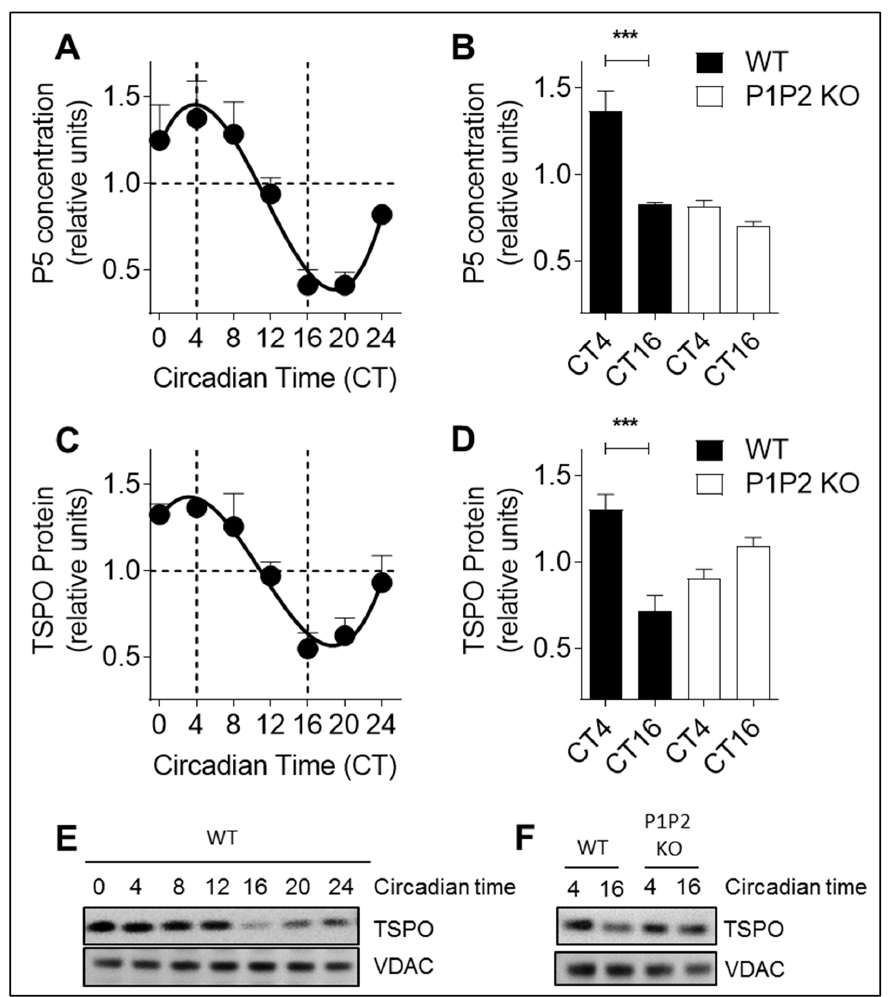
Figure 2. Pregnenolone and TSPO oscillations are dependent on a functional circadian clock in mouse brains. ( A ) P5 concentration was quantified in brain homogenates from non-fasted wild-type mice kept in constant darkness using a direct pregnenolone ELISA test. Circadian times from CT0 to CT24 are shown. All data are normalized to 1 and presented as mean ± SEM (one experiment, seven time points, n = 3–4 for each time point). ( B ) Variations in P5 concentration are abolished in PER1 / PER2 (P1P2) knock-out (P1P2 KO) mice. P5 levels at peak and trough corresponding to CT4 and CT16 from brain homogenates of wild-type (WT) mice compared to P1P2 KO mice. All data are normalized to 1 and presented as mean ± SEM (WT and P1P2 KO: one experiment, two time points, n WT = 8 and n P1P2 KO = 3–4 for each time point). *** p < 0.001 (unpaired Student’s t -test). ( C ) TSPO protein levels were analyzed in brain homogenates from non-fasted wild-type mice kept in constant darkness by immunoblotting. Circadian times from CT0 to CT24 are shown. All data are normalized to 1 and presented as mean ± SEM (one experiment, seven time points, n = 2–3 for each time point). ( D ) Variations in TSPO protein levels are abolished in PER1 / PER2 (P1P2) knock-out (P1P2 KO) mice. TSPO levels at peak and trough corresponding to CT4 and CT16 from brain homogenates of WT mice compared to P1P2 KO mice. All data are normalized to 1 and presented as mean ± SEM (WT and P1P2 KO: one experiment, two time points, n WT = 8 and n P1P2 KO = 3–4 for each time point). *** p < 0.001 (unpaired Student’s t -test). ( E , F ) Representative immunoblots of brain lysates from non-fasted wild-type mice kept in constant darkness stained with antibodies specific for TSPO and VDAC (control). ( E ) Circadian times from CT0 to CT24 are shown for wild-type animals (WT). ( F ) Circadian times CT4 and CT 16 (corresponding to peak and trough) are shown for WT and PER1 / PER2 knock-out (P1P2 KO)